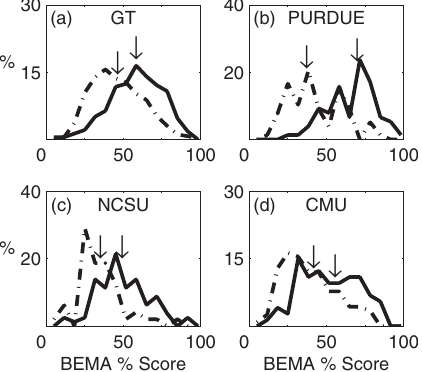
FIG. 2. Postinstruction BEMA score distributions at four aca- demic institutions—the percentage of students with a given BEMA test score is plotted for students who have completed an E&M course with either a traditional (cid:1) dotted-dashed line (cid:2) or M&I curricu- lum (cid:1) solid line (cid:2) at (cid:1) a (cid:2) GT, (cid:1) b (cid:2) Purdue, (cid:1) c (cid:2) NCSU, and (cid:1) d (cid:2) CMU. The arrows indicate the location of the average score for each distribu- tion. The rightmost arrow in each subfigure corresponds to the M&I course. The total number of students tested in each curriculum at each institution is the same as in Fig. 1. The plots are constructed from binned data with bin widths equal to approximately 6.7% of the maximum possible BEMA score (cid:1) 100% (cid:2) .